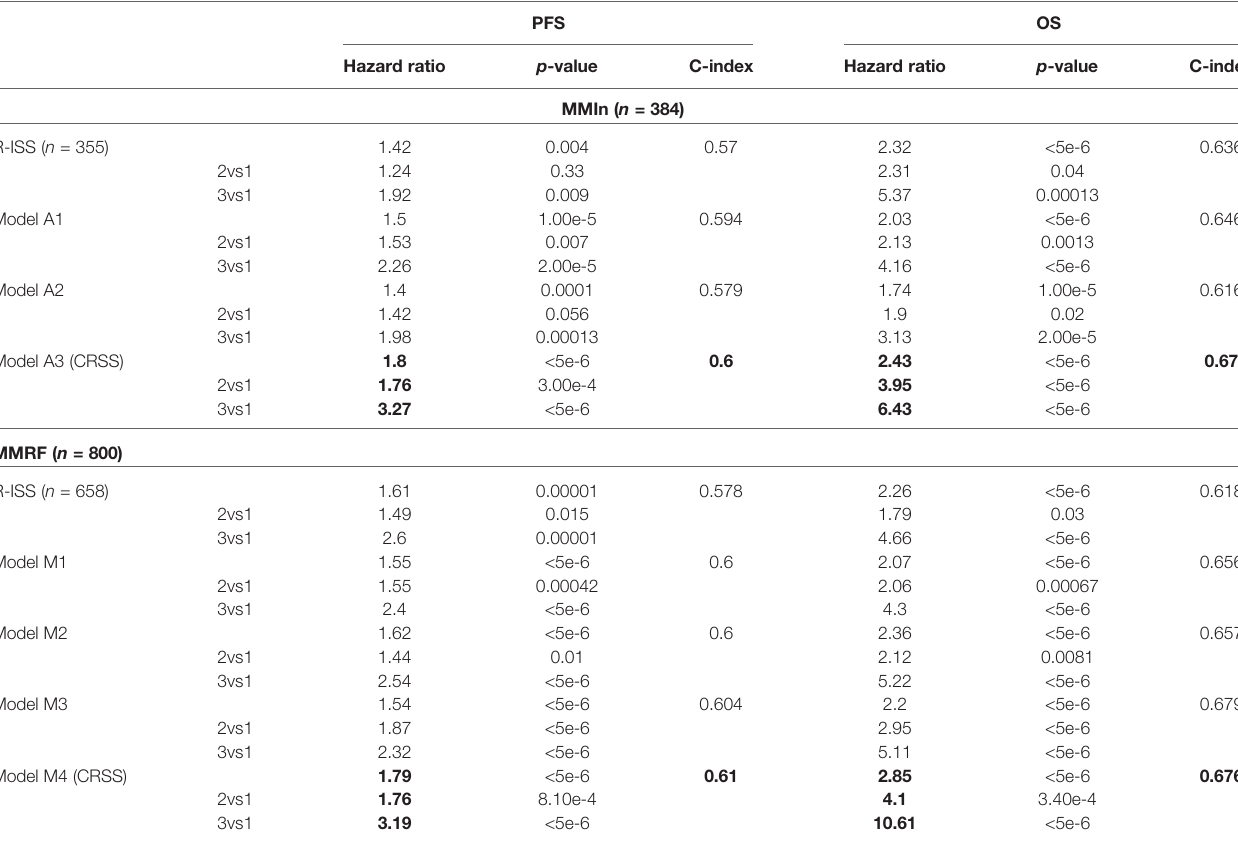
TABLE 2 | Comparison of different models devised for the risk strati fi cation of patients in the MMIn and MMRF cohorts with the R-ISS. PFS OS Hazard ratio p